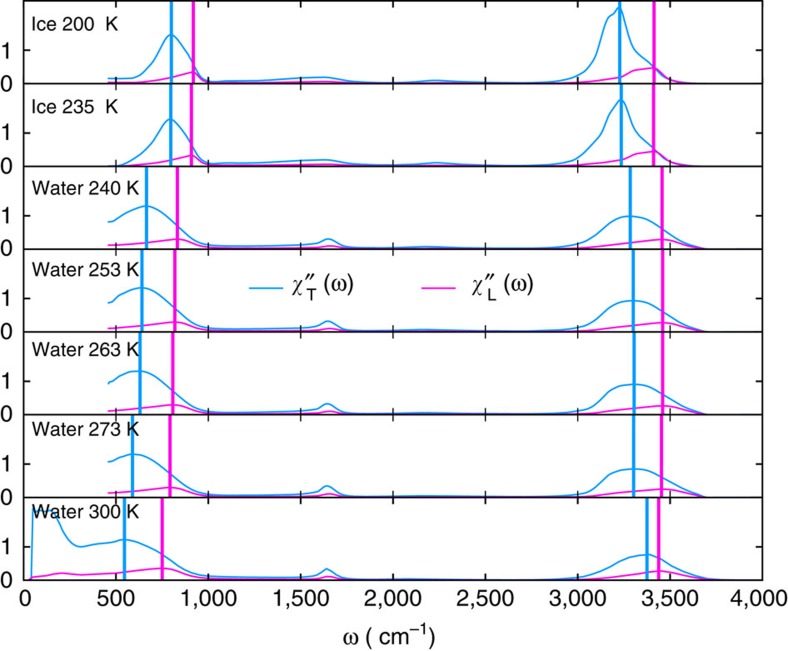
Dielectric susceptibilities of ice and water.Computed from index of refraction data using equations 4 and 6. data from 210 to 280 K comes from aerosol droplets34 while the data at 300 comes from bulk liquid35.